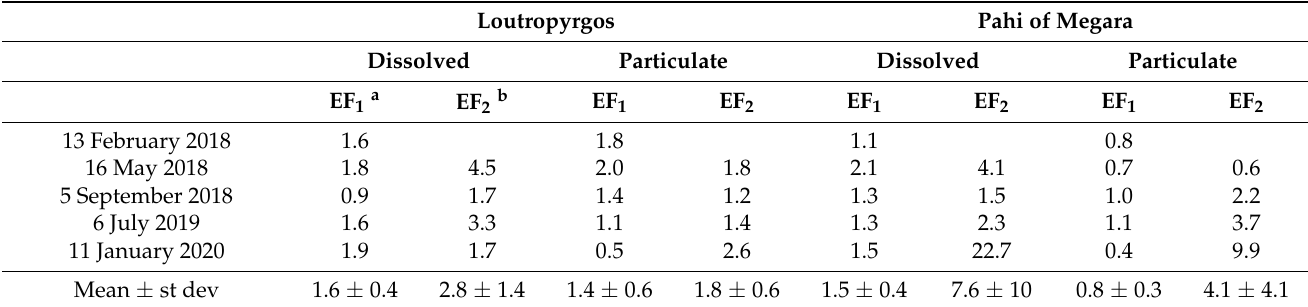
Table 3. Enrichment factors (EF 1 , EF 2 ) of ∑ PAHs in the dissolved and particulate phases. Loutropyrgos Pahi of Megara Dissolved Particulate Dissolved